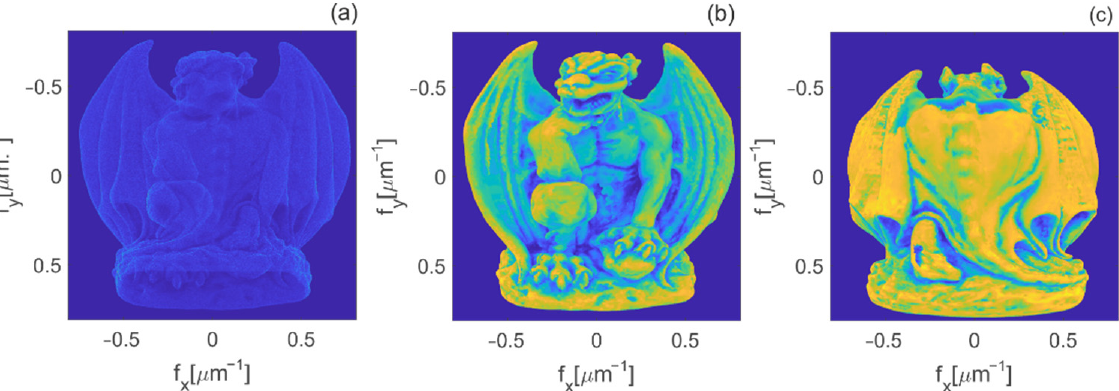
Figure 4. Frequency mapping of the point cloud when using PAS for the segment m = 1, n = 1. ( a ) PAS without occlusion. ( b ) Front and ( c ) back of the gargoyle when applying PAS-based occlusion